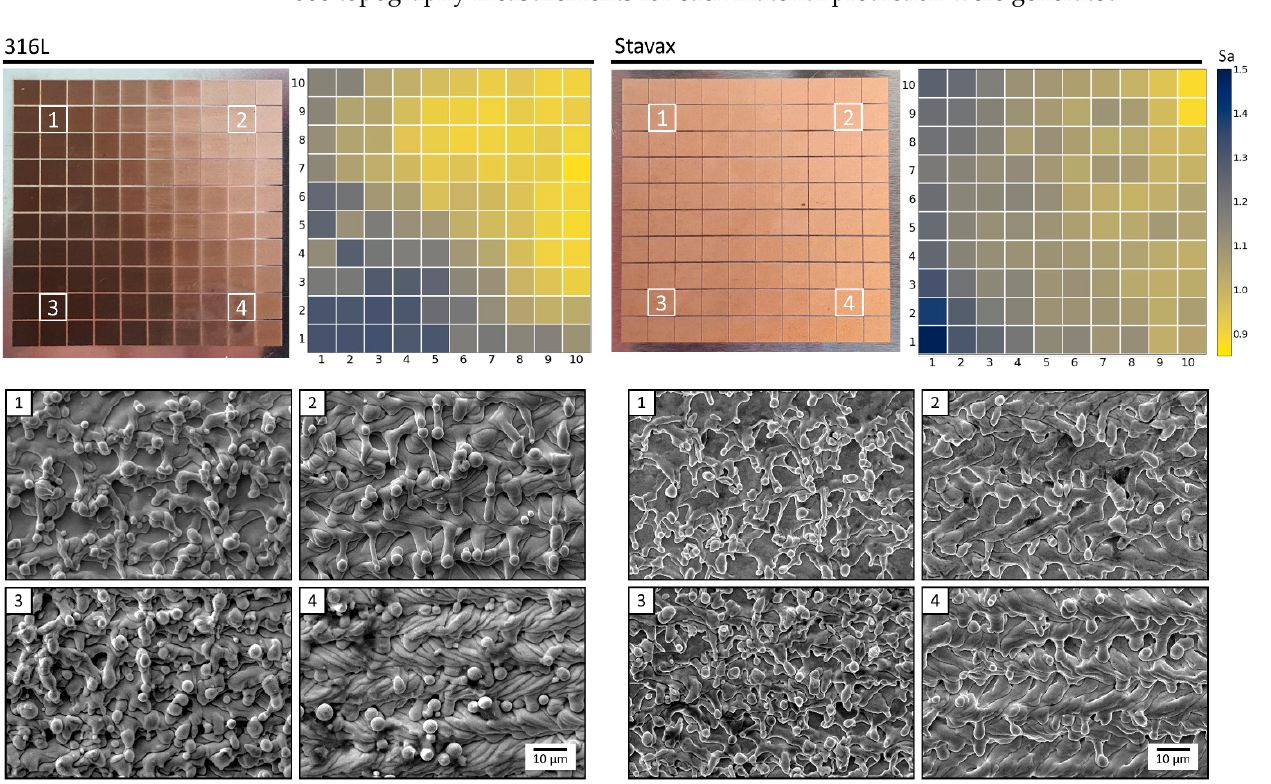
Figure 2. Exemplary laser treated surface and resulting roughness (Sa) values for constant laser power of 18 W and frequencies (repetition rate) from 110 kHz to 200 kHz ( bottom – top ) and scanning speed from 1.1 m/s to 2.0 m/s ( left to right ) for the materials 316L ( left ) and Stavax ( right ). SEM images of the textured surface for both materials and four different process parameters ( 1 – 4 )